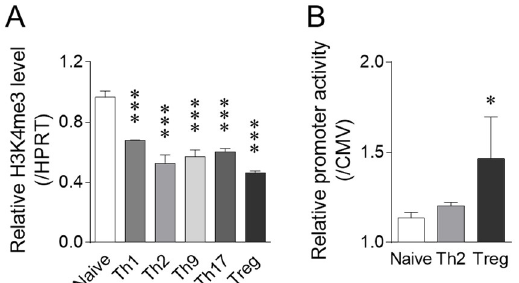
Figure 3. Chrna9 gene H3K4me level and promoter activity. H3K4me3 level ( A ) and promoter activity ( B ) in T-cell subsets and naive CD4 + T cells were determined as described in Materials and Methods. Data are expressed as means ± SD normalized to H3K4me3 levels in the Hprt gene ( A ) and to CMV promoter activity ( B ), respectively ( n = 3). * p < 0.05, *** p < 0.001, compared with naive CD4 + T cells (Dunnett’s test).